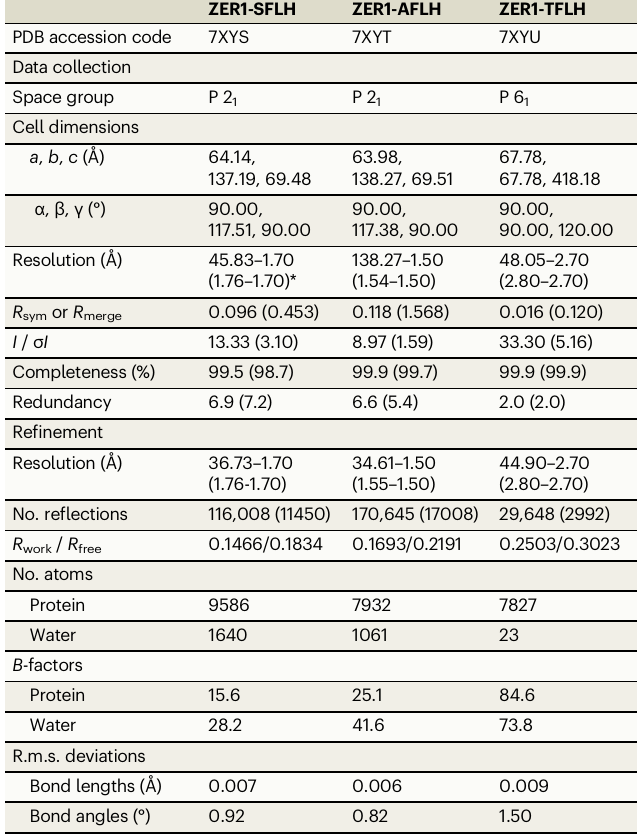
*Values in parenthesesareforhighest-resolution